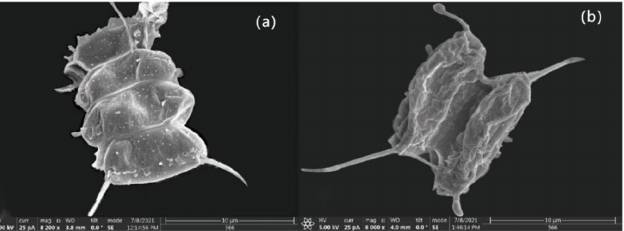
Figure 2. Scanning electron micrographs of Scenedesmus quadricauda : ( a ) HgCl 2 0 mg/L; ( b ) HgCl 2 0.9 mg/L for 9 days. Water 2022 , 14 , 3228